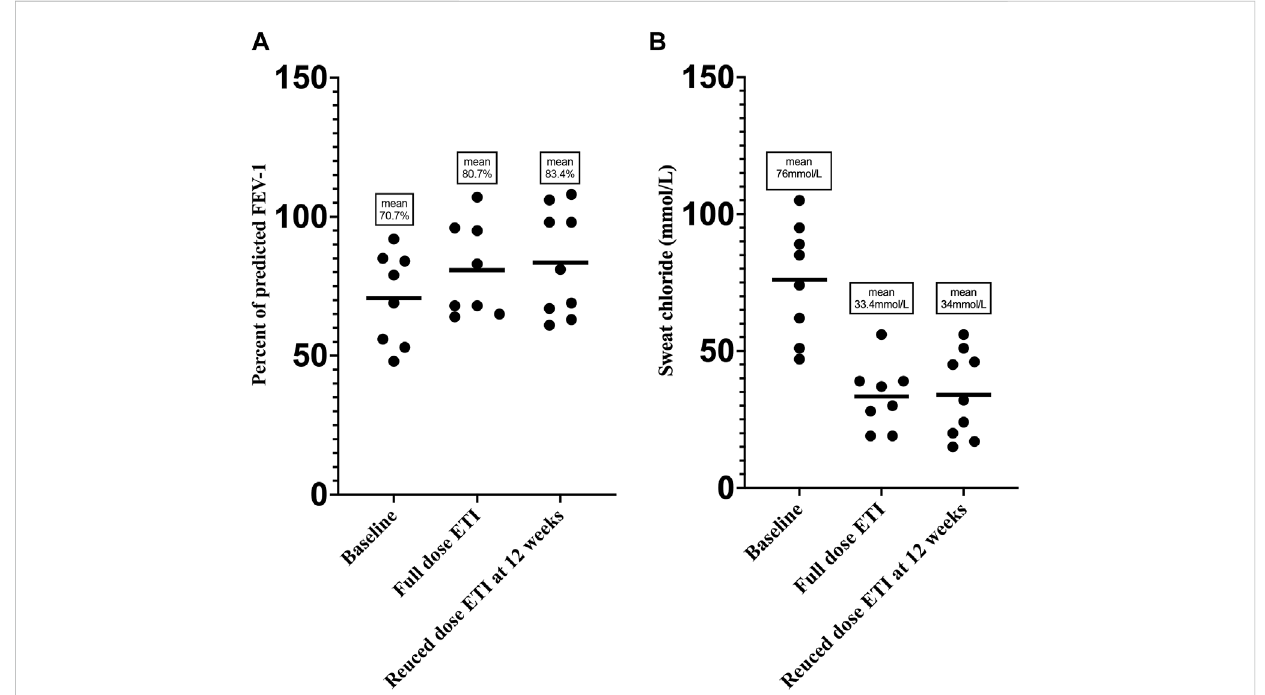
FIGURE 2 Change in (A) FEV 1 and (B) sweat chloride at baseline, on full standard dose, and reduced dose of ETI therapy.